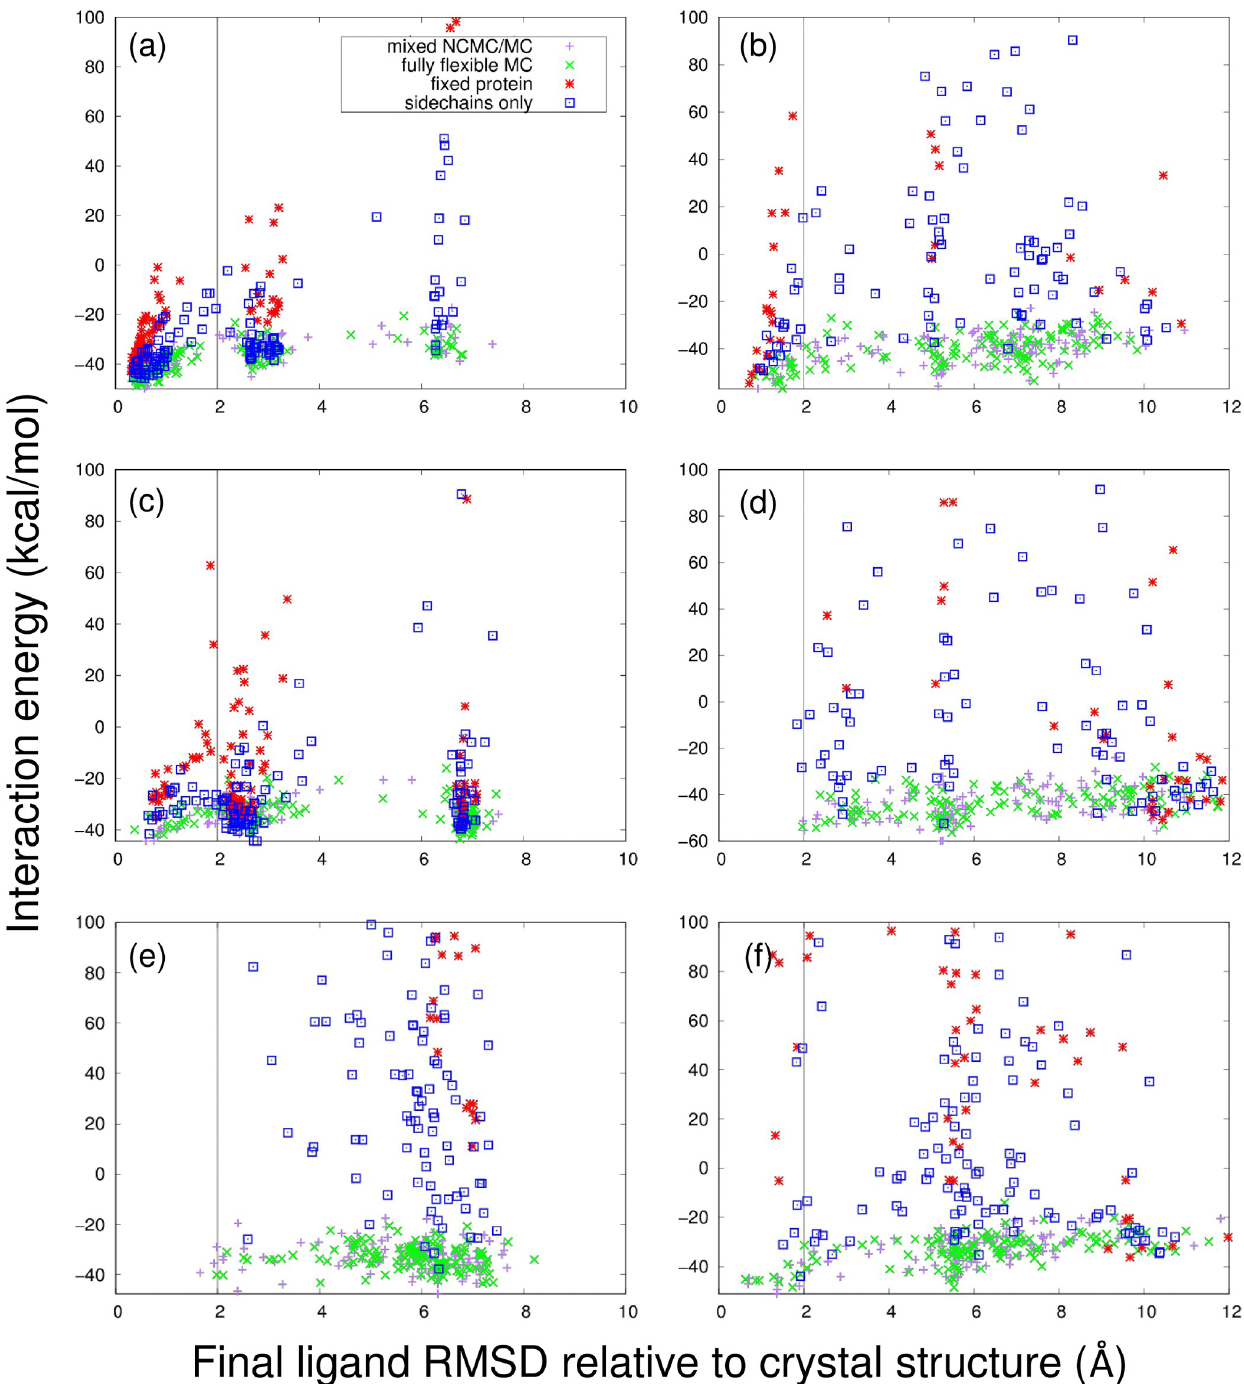
Fig 5. Example ensemble redocking and cross-docking runs for simulations incorporating different levels of flexibility. Plot of final ligand RMSD relative to crystal structure vs. interaction energy for (a) estradiol (redocking); (b) 4-hydroxytamoxifen (redocking); (c) genistein (cross-docking); (d) raloxifene (cross-docking); (e) the drug 1GJ; (f) the drug 369. (For structures of the drugs, see Fig 3.) (a), (c), and (e) are agonists, whereas (b), (d), and (f) are antagonists. In each plot, results for a fully flexible protein are in green (for MC only) or purple (for the mixed NCMC/MC simulations), whereas results for docking simulations in which the entire protein or just its backbone are fixed (MC only simulations) are in red or blue respectively. In order to make the results for the fully flexible protein visible, the vertical axis for each plot is cut off at 100 kcal/mol; as a result, some of the docking runs for the fixed protein are not shown due to their high